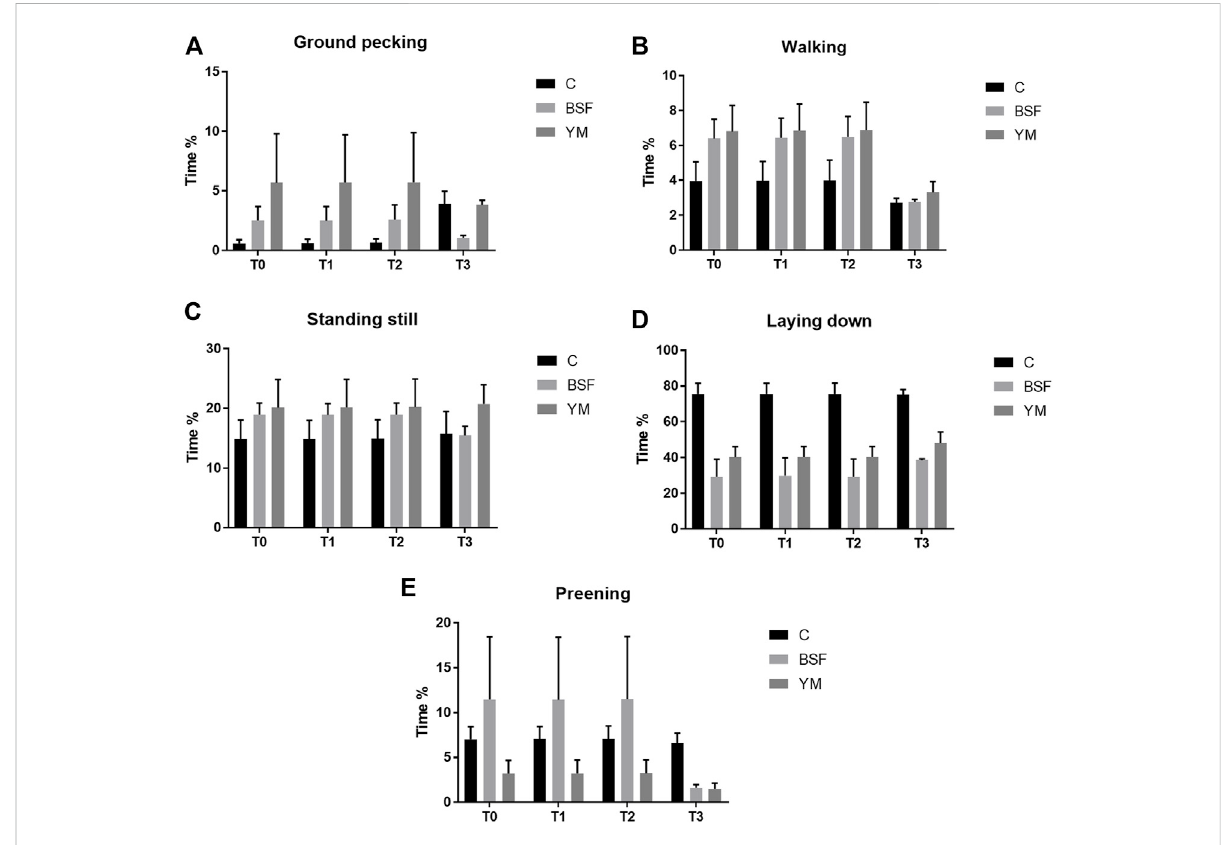
FIGURE 5 Duration behaviours of the broiler chickens during the larvae intake (diet*time interaction, p > 0.05). (A) Preening. (B) Allopreening. (C) Stretching. (D) Wing fl apping. (E) Shaking.C=controlgroup;BSF=Cdiet+blacksoldier fl ylivelarvae;YM=Cdiet+yellowmealwormlivelarvae.T0 = day 0; T1 = day 11; T2 = day 22; T3 = day